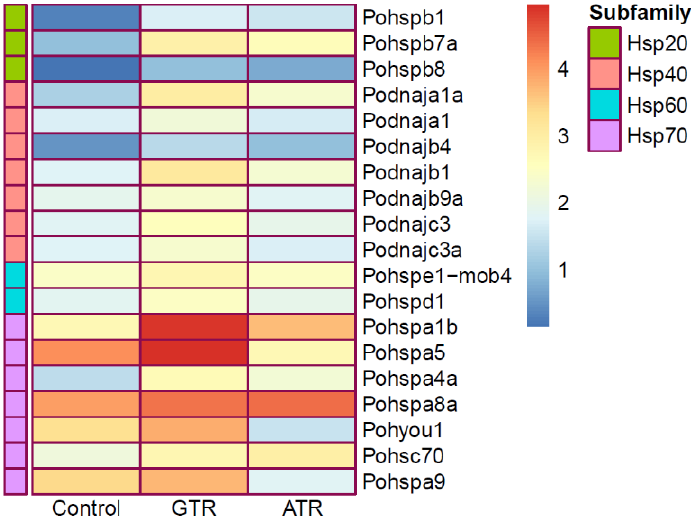
Figure 6. The response of the mitogen-activated protein kinase signaling (MAPK) pathway after two kinds of heat stress. Note: The blue bar represents the GTR while the red bar represents ATR; the up-regulated genes are above the line while the down-regulated genes are below the line.